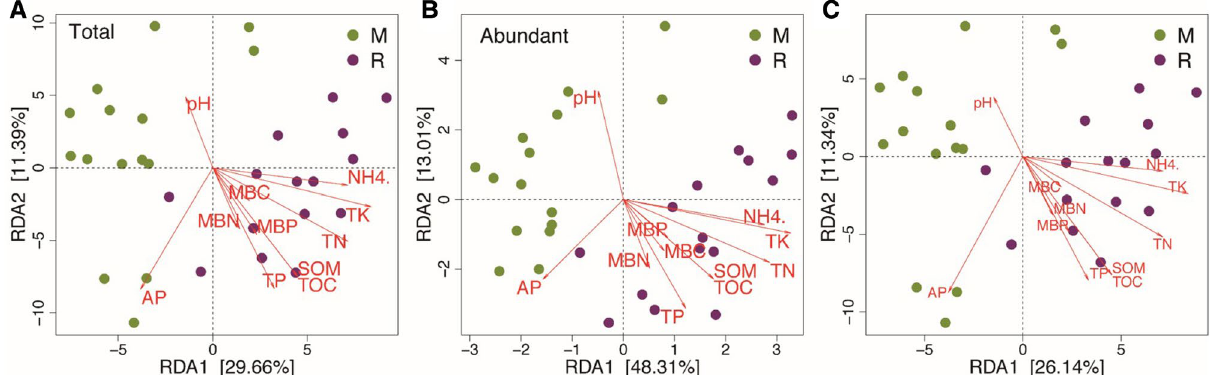
Figure 6. Redundancy analysis (RDA) ordination biplots of the total ( A ), abundant ( B ) and rare ( C ) bacterial community in relation to soil environmental variables. Arrows indicate directions of maximum variation of environmental variables; length of arrows indicates their importance. Each circle colored by two crop management represents the bacterial community for each sample. TOC total organic carbon, TN total nitrogen, TP total phosphorus, TK total potassium, NO 3– -N nitrate nitrogen, NH 4+ -N ammonium nitrogen, AP available